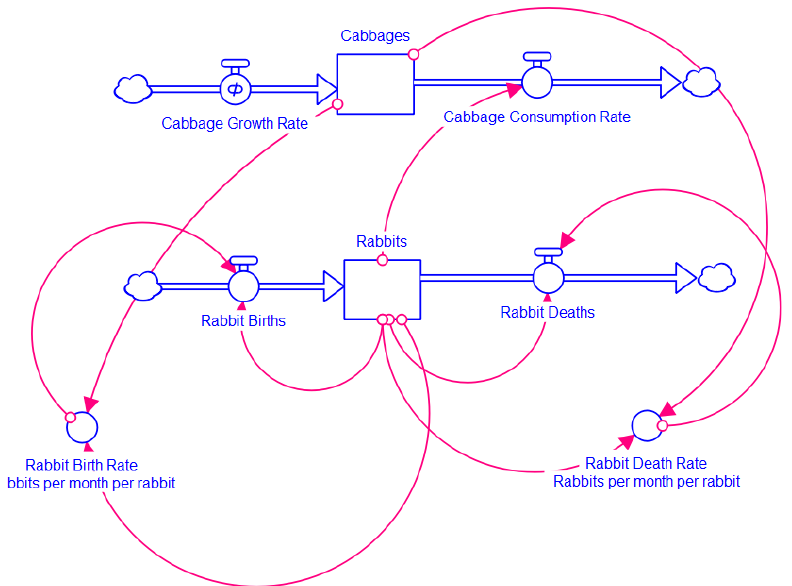
Fig. 26. Predator-prey stock-and-flow diagram